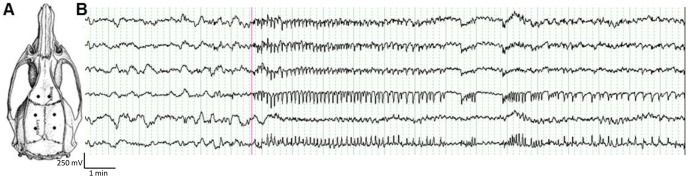
A typical seizure on EEG in a post-KA SE rat.(A) Position of recording electrodes on rat skull (adapted from Paxinos and Watson [46]). (B) The EEG trace shows a typical seizure in a rat 6 weeks post-KA SE demonstrating the abrupt onset of evolving rhythmic spike and wave activity from normal drowsy background EEG. Recording voltage is 50 µV/min.